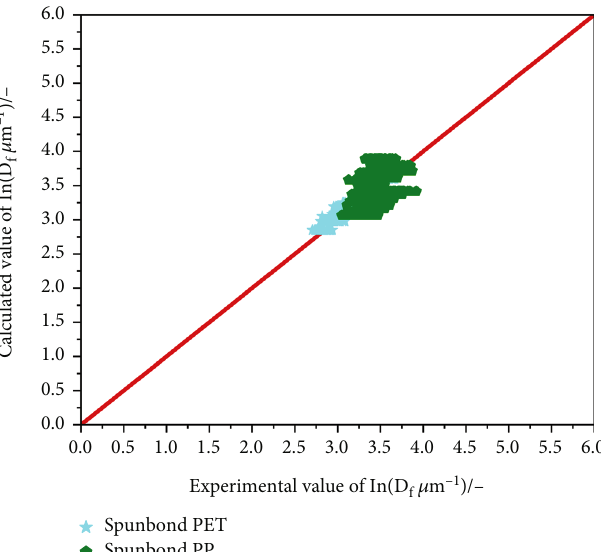
Figure 12: Comparison of the predicted and measured fi bre diameters on the second spinning device using the fi xed output parameter with the new machine